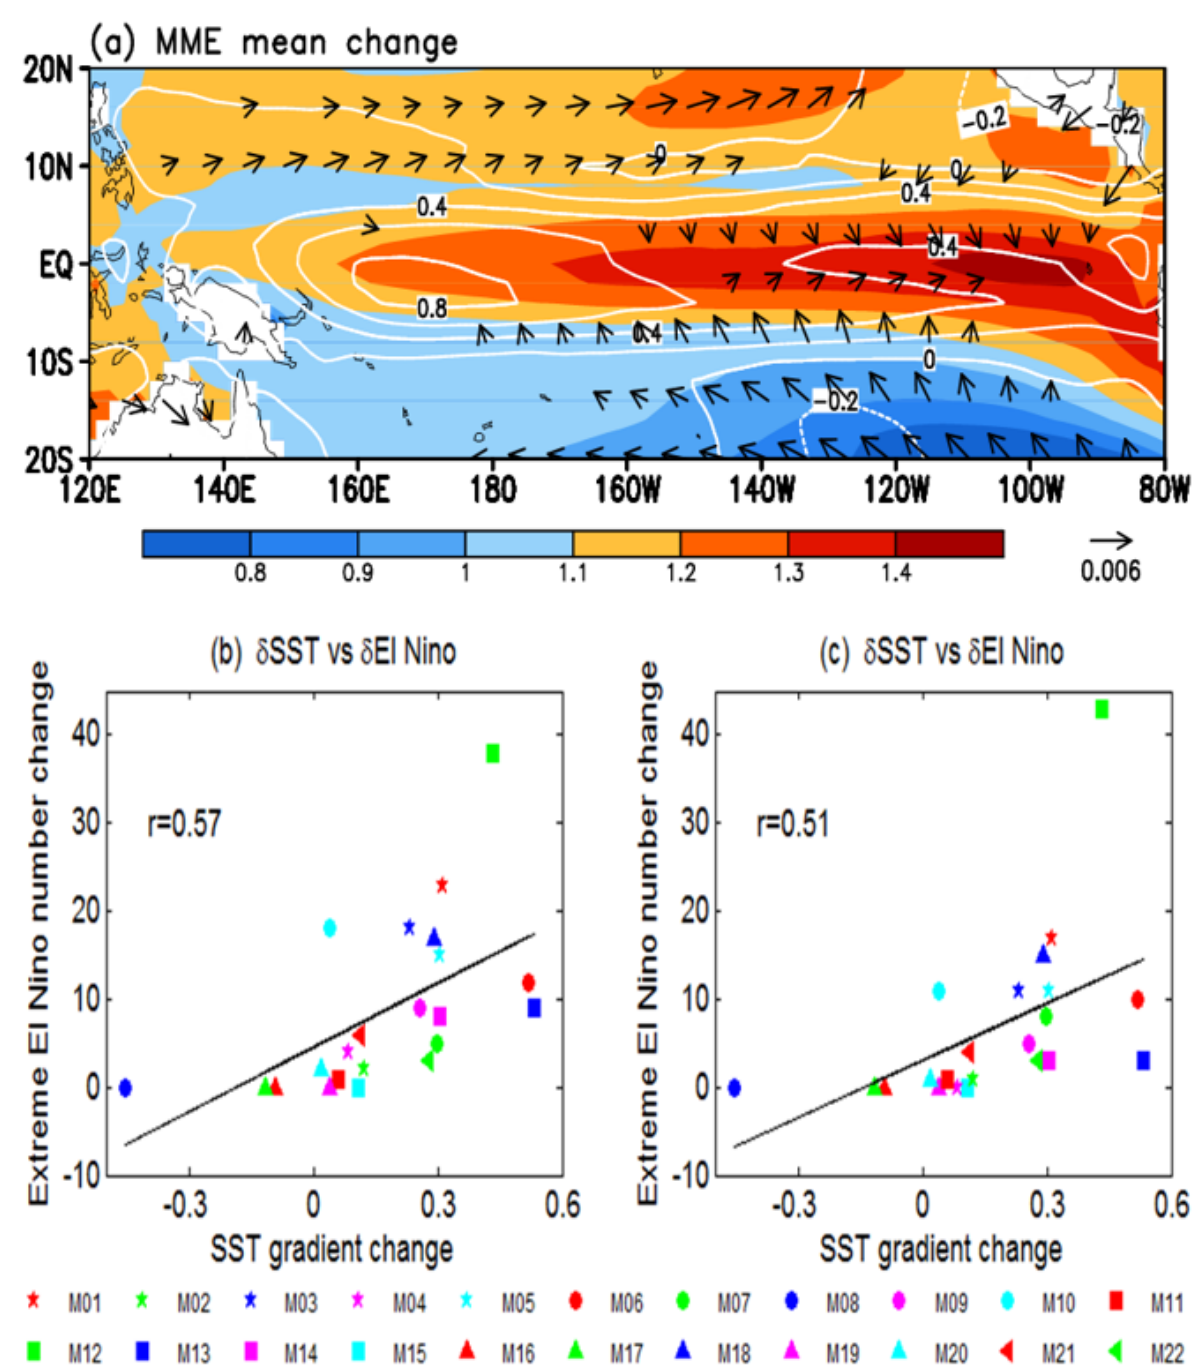
Figure 6. ( a ) The MME mean changes for surface wind stress (N/m 2 ; vectors), precipitation (mm/day; white contours), and SST ( ◦ C; color-shaded) projected by 22 CMIP5 models under RCP 8.5 forcing. ( b ) Scatterplot of the projected changes in the number of extreme El Niño events versus east–west gradient changes in SST between the eastern (140 ◦ W–90 ◦ W, 2 ◦ S–2 ◦ N) and western (140 ◦ E–170 ◦ W, 2 ◦ S–2 ◦ N) equatorial Pacific in models. An extreme El Niño in ( b ) was identified when the Niño3 mean DJF precipitation was over 5 mm/day. ( c ) Same as ( b ), but an extreme El Niño event was identified when the Niño3 mean DJF precipitation was over 6 mm/day.